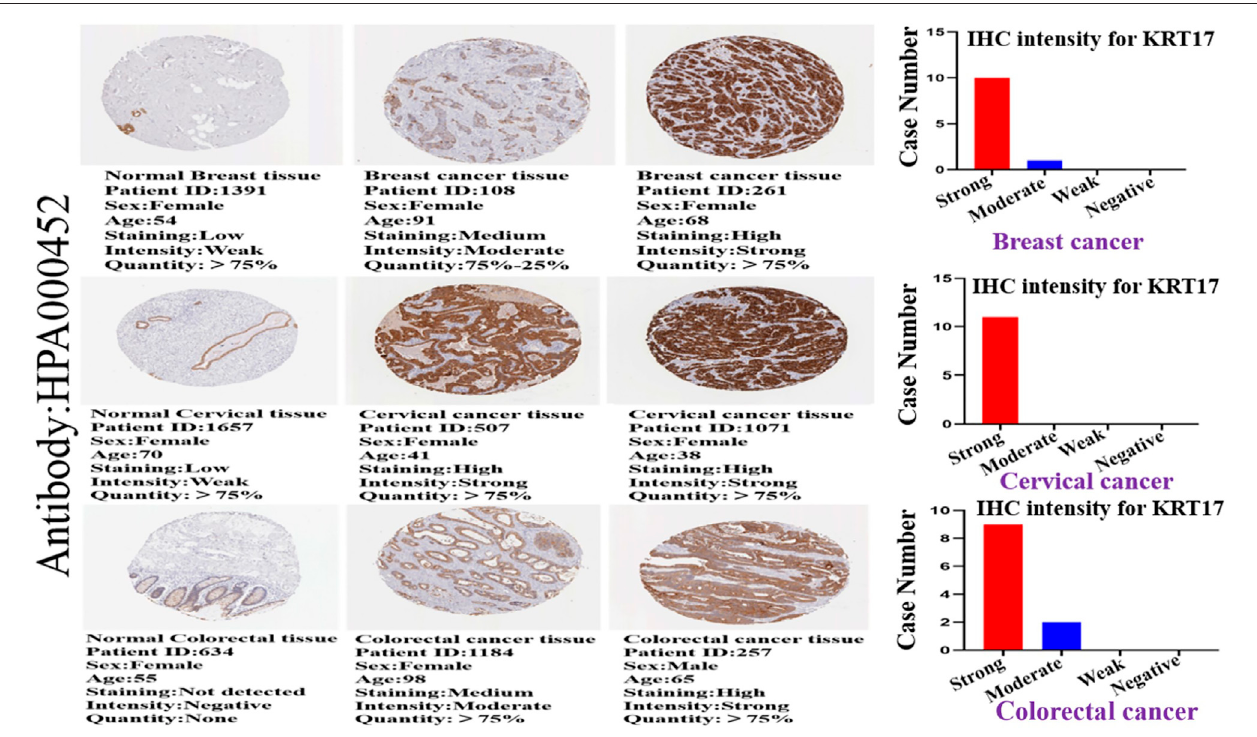
FIGURE3| Immunohistochemical(IHC)imagesofnormalandtumortissuesofKRT17frompatientswithbreastcancer,cervicalcancer,andcolorectalcancer,and the intensity of the IHC of KRT17. The bar graph shows the IHC intensity of KRT17 (breast cancer: 11 patients, cervical cancer: 11 patients, and colorectal cancer: 11 patients). All IHC images and patient information were derived from the